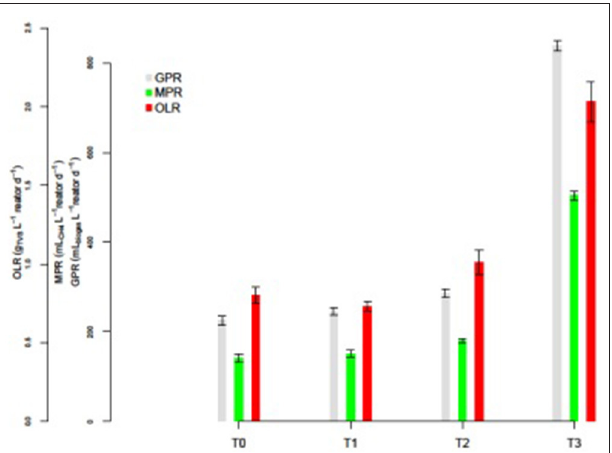
FIGURE 5 | The pH of the feed stream and of the digestate, the specific methane production (SMP), and the specific energy loading rate of the system